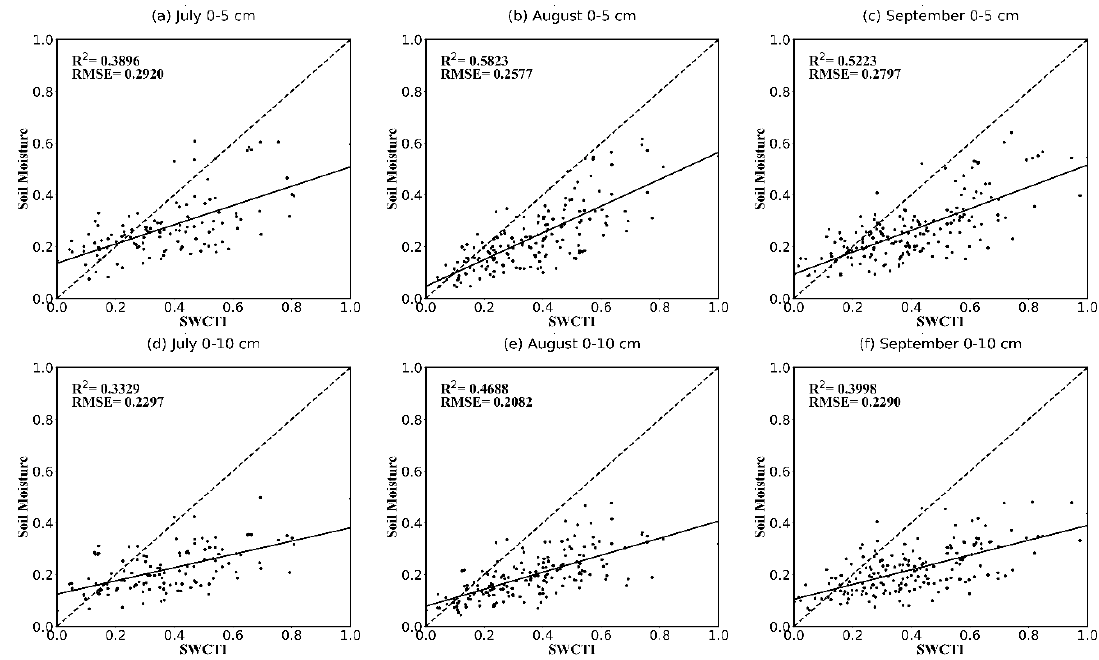
Figure 10. Scatterplots of SWCTI vs. in situ soil moisture for different soil depths and months, (a) 0–5 cm in July, ( b ) 0–5 cm in August and ( c ) 0–5 cm in September; ( d ) 0–10 cm in July, ( e ) 0–10 cm in August and ( f ) 0–10 cm in September. Table 2. Correlations between SWCTIand soil moisture at different soil depths and during different months.